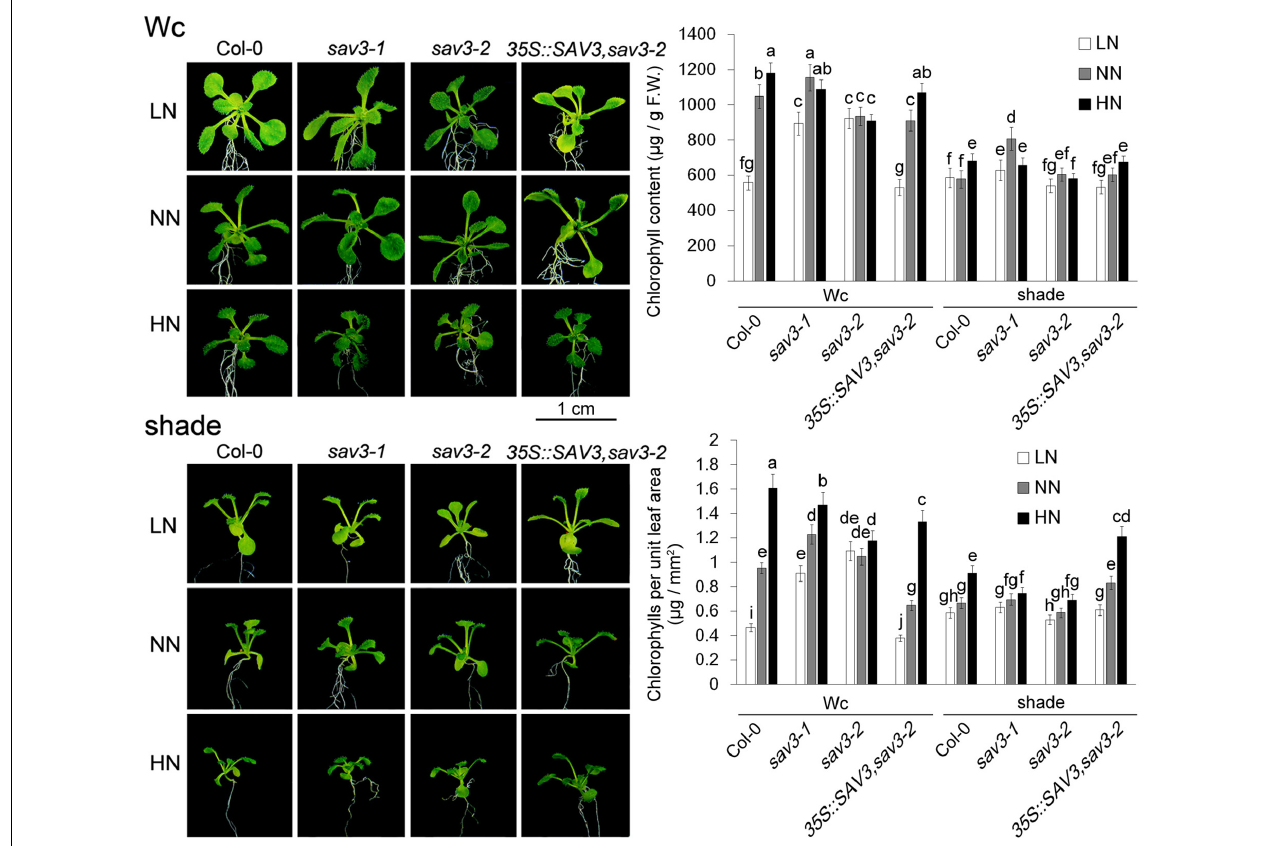
FIGURE 6 | Chlorophyll accumulation induced by high-N treatment declined under shade condition. Chl content per fresh weight and Chl content per unit leaf area of 14-day-old seedlings under different N levels with or without shade treatment were determined. F.W., fresh weight; Wc, continuous white light; LN, low N condition; NN, normal N condition; HN, high N condition. Phenotypes are shown in the left panel; quantitative data are shown in the right panel. Bars represent standard deviations of three independent replicates. Values followed by different letters are significantly different at P < 0.05 according to Duncan’s multiple range test.